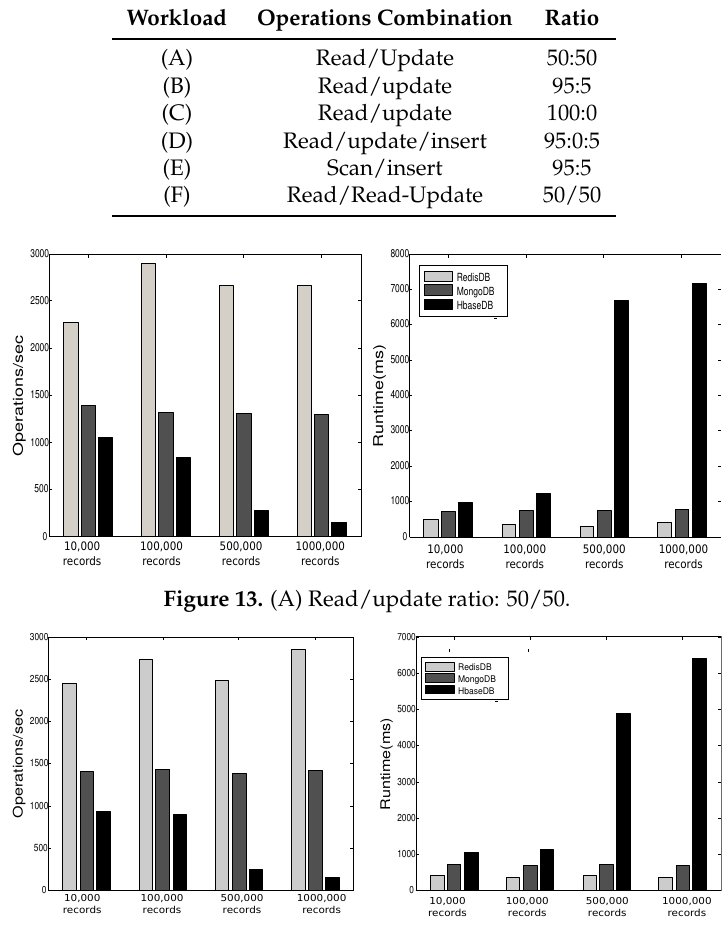
Figure 14. (B) Read/update ratio: